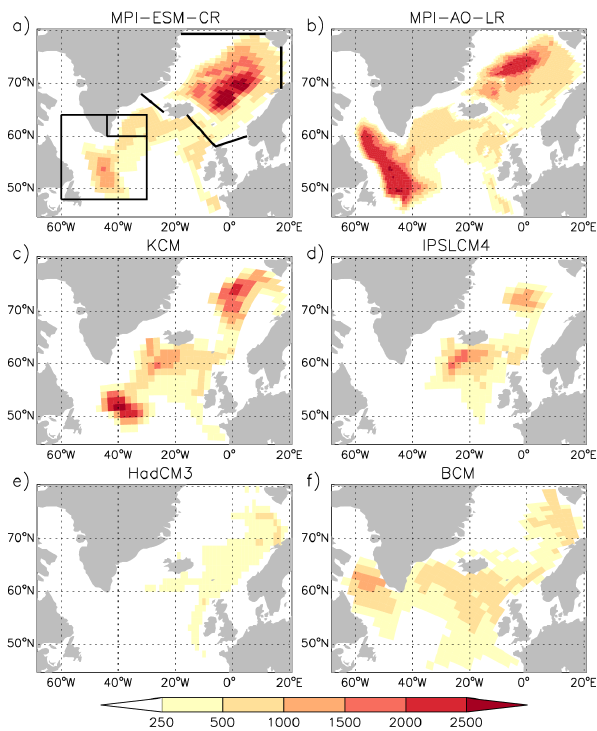
Fig. 2. Mean mixed layer depth in March (in metres) in the con- trol simulation with (a) MPI-ESM-CR, (b) MPI-AO-LR, (c) KCM, (d) IPSLCM4, (e) HadCM3 and (f) BCM. The boxes in (a) indi- cate the area where in the sensitivity experiments temperature and salinity are relaxed towards climatological values.